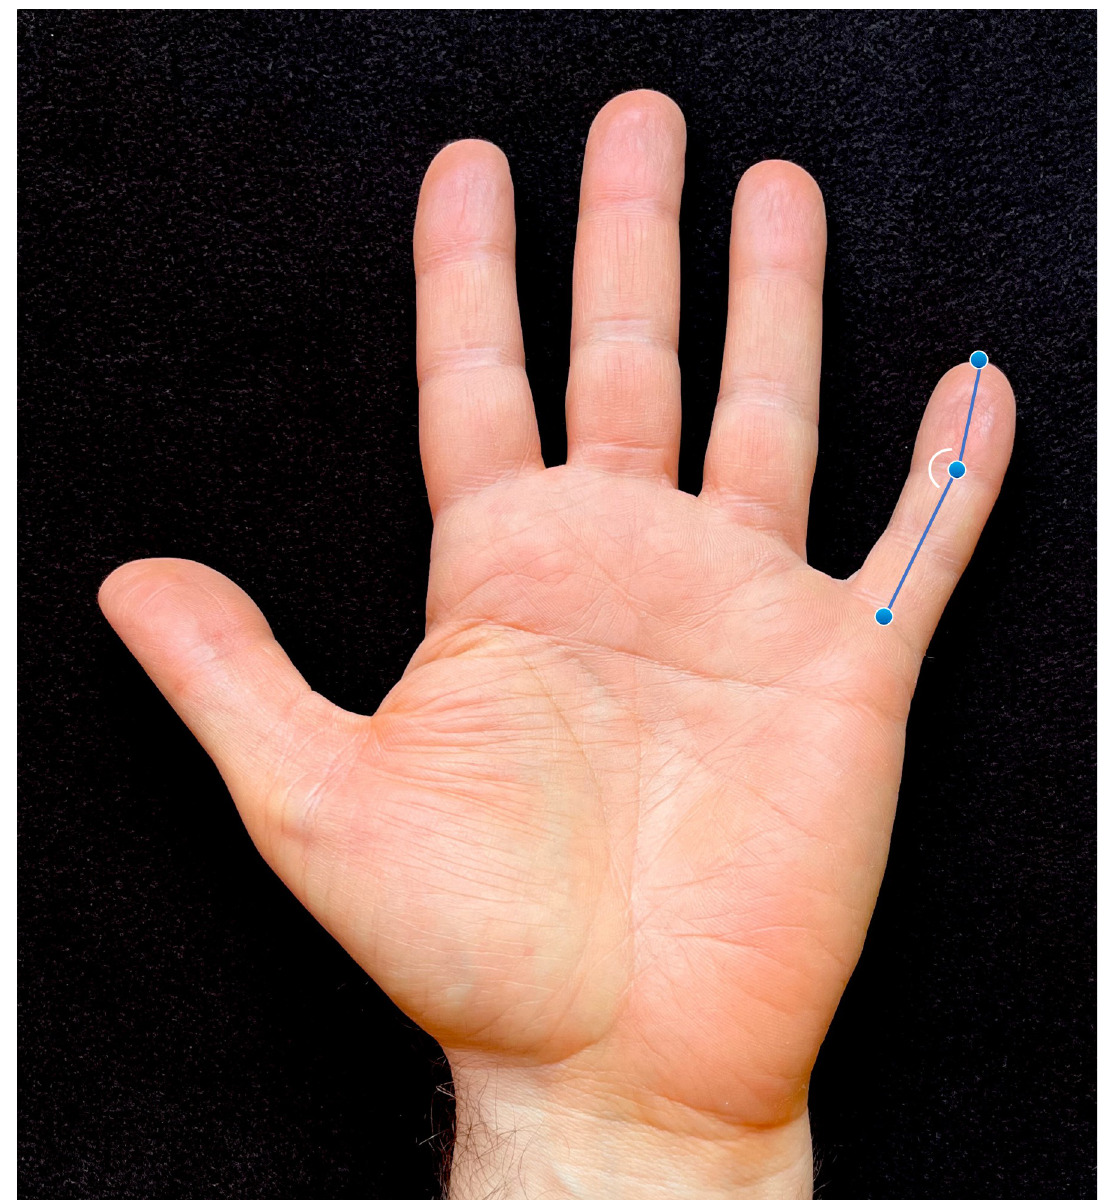
Fig 1. Image showing landmarks used to quantify fifth finger curvature. Landmarks (proximal to distal) include the midpoint of the metacarpophalangeal crease, the distal interphalangeal joint, and the distal margin of the fingertip. The inner angle formed by these points was used to measure the degree of